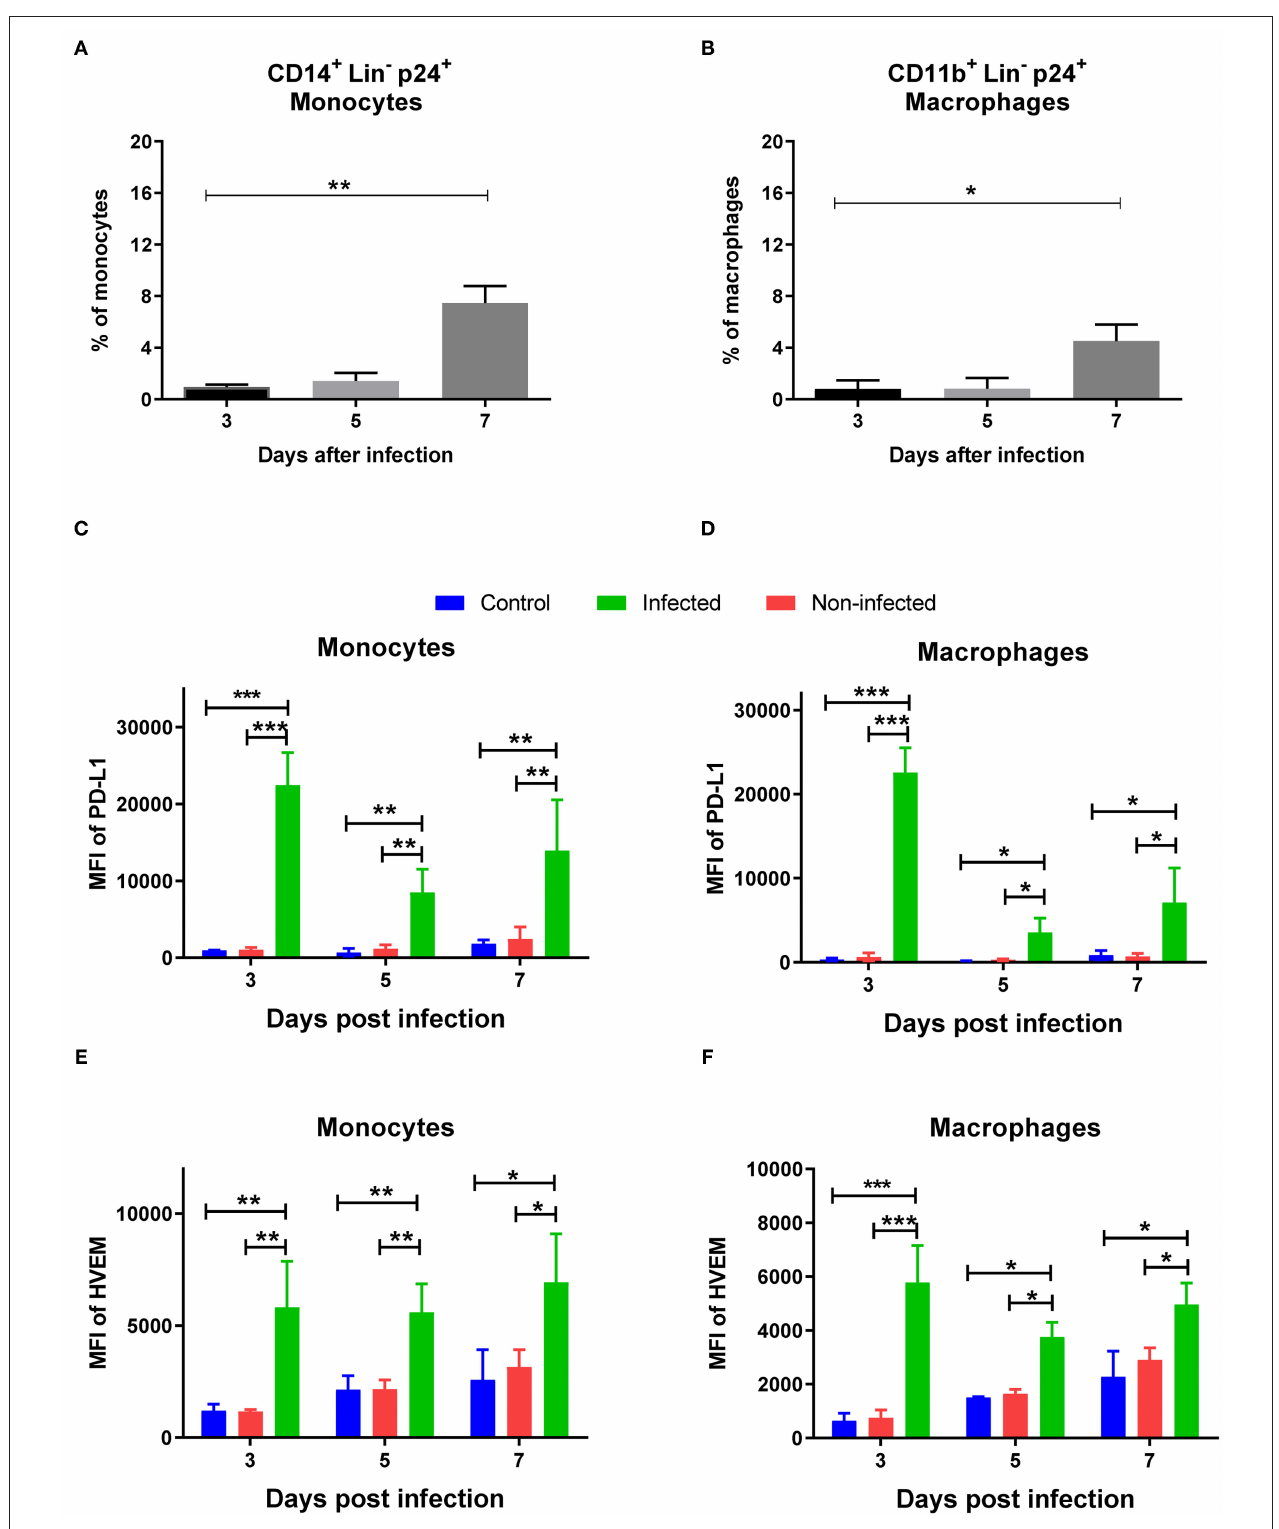
FIGURE 6 | Expression of PD-L1 and HVEM on HIV-1 infected human myeloid cells. Human PBMCs were stimulated with PHA and IL-2 prior to infection with HIV-1 and were analyzed on day 3, 5, 7 after infection. Multi-parameter flow cytometry analysis was used to compare the percentage of p24 on different subpopulations